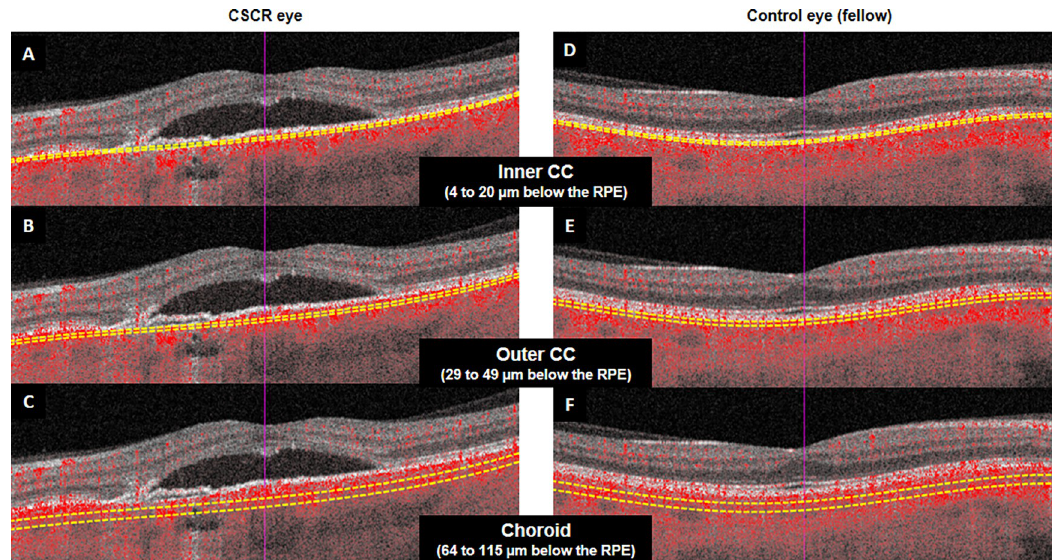
Fig 1. This image shows the B-scan of the optical coherence tomography with flow superposition and the three different slabs studied segmented: 1) inner choriocapillaris (CC, 4 to 20 μ m below the retinal pigment epithelium, RPE), 2) outer CC (29 to 49 μ m below the RPE) and 3) choroid (CH, 64 to 115 μ m below the RPE) in central serous chorioretinopathy (CSCR) and fellow eyes.